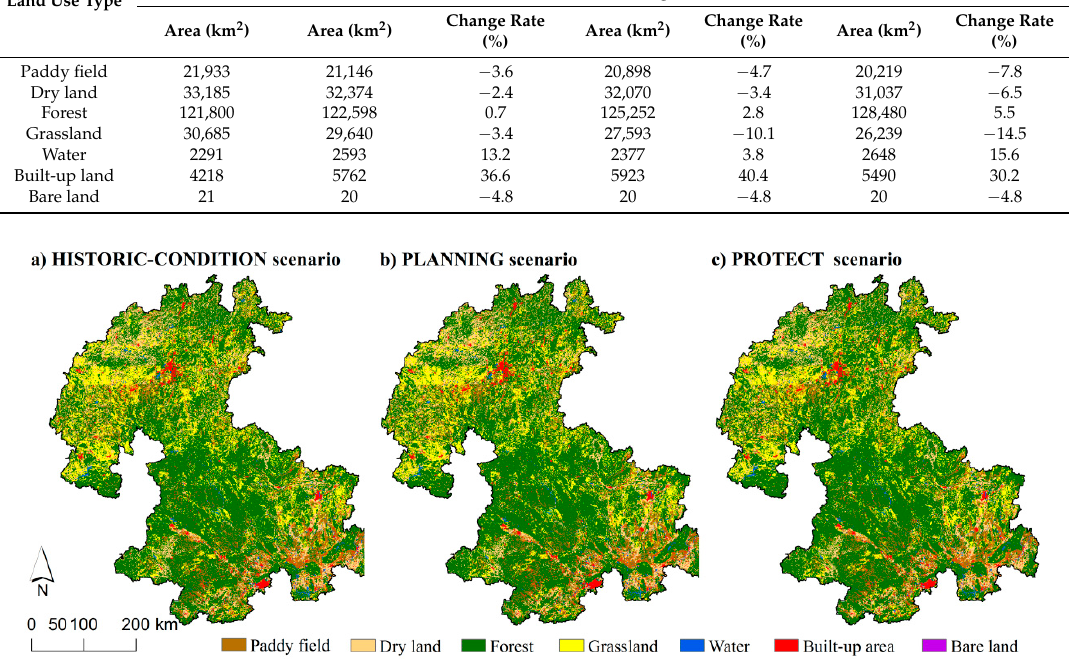
Figure 9. Projection of land use 2015 under the ( a ) history trend scenario (HISTORIC-CONDITION); ( b ) socioeconomic priority scenario (PLANNING); ( c ) Ecological protection scenario (PROTECT).